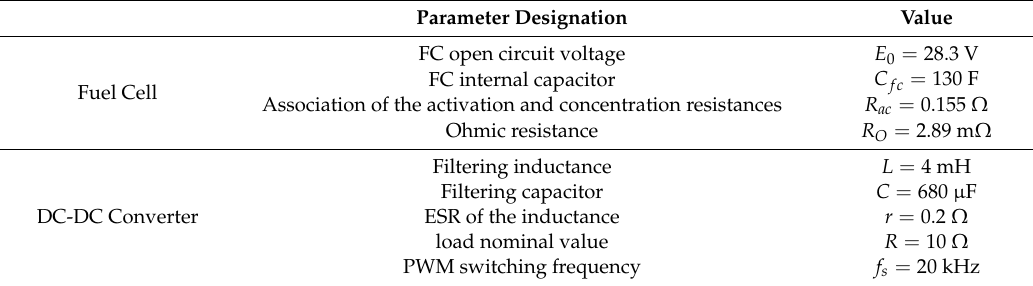
Table 2. Controlled system parameters: fuel cell and DC-DC